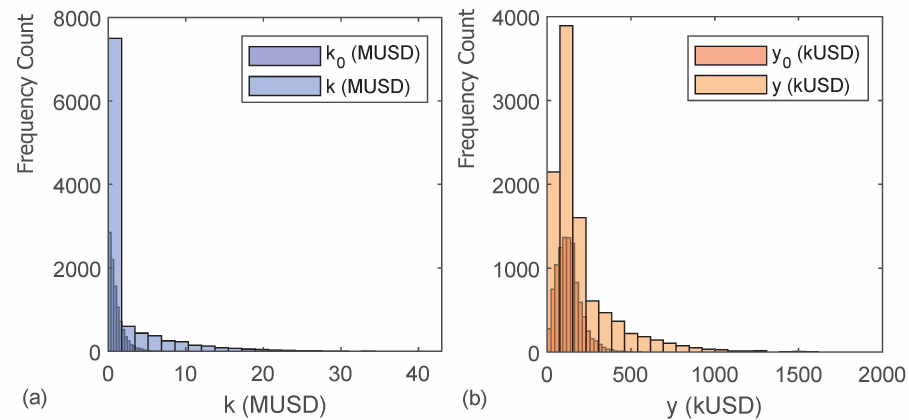
Figure 3. Distributions of initial and final capital and income in a n = 10,000 population after 73 years with Keynesian tax policy. ( a ) Capital. ( b ) Income.